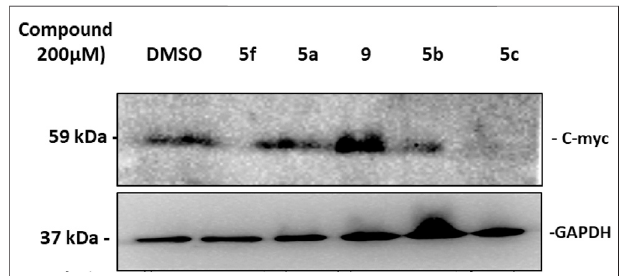
FIGURE 6 | Western blot of C-myc expression in KF-28 cells treated eitherwithDMSO or compounds 5a – c,5f,and 9for twodays.The celllysates were developed and fractionated by 15% SDS-PAGE, blotted, and probed with anti-C-myc Ab to show its relative expression. Appreciated downregulation of C-myc expression under treatment with 5f, 5b, and 5c is shown. The lower band is GAPDH which was used as a loading control.